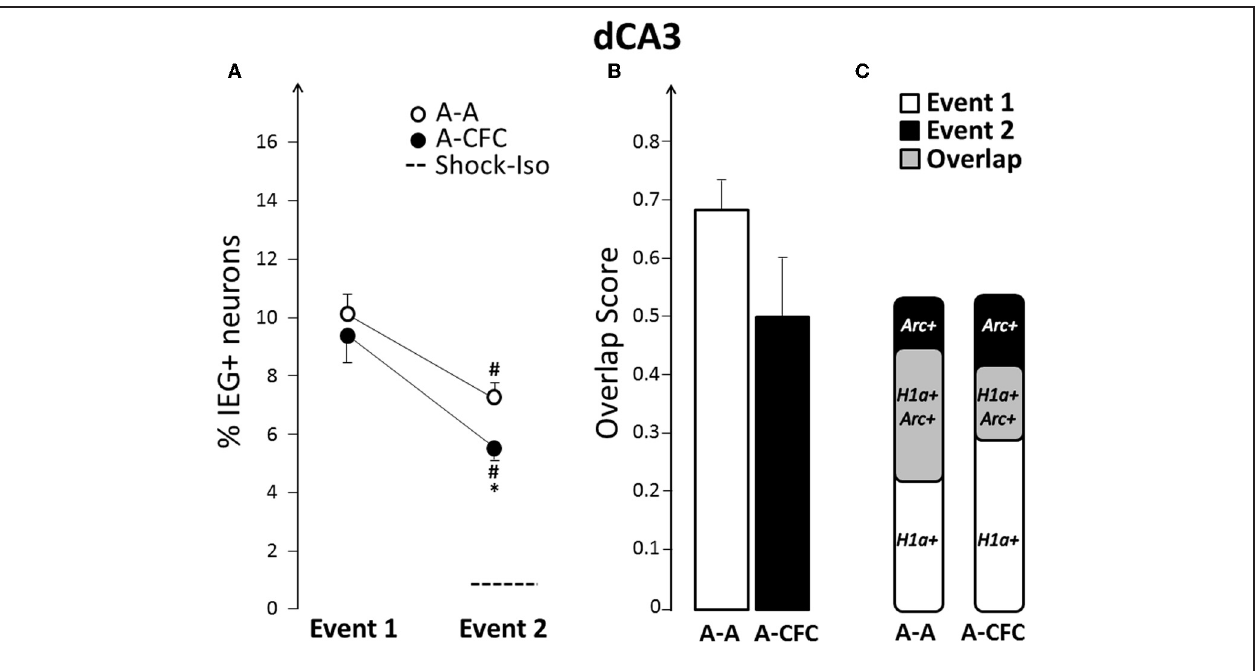
FIGURE 4 | Comparison of ensemble size and overlap between dCA3 ensembles activated during both events in A-A and A-CFC groups: (A) Size of IEG-expressing ensembles expressed as percentage of total cells. The dashed line is the percentage of